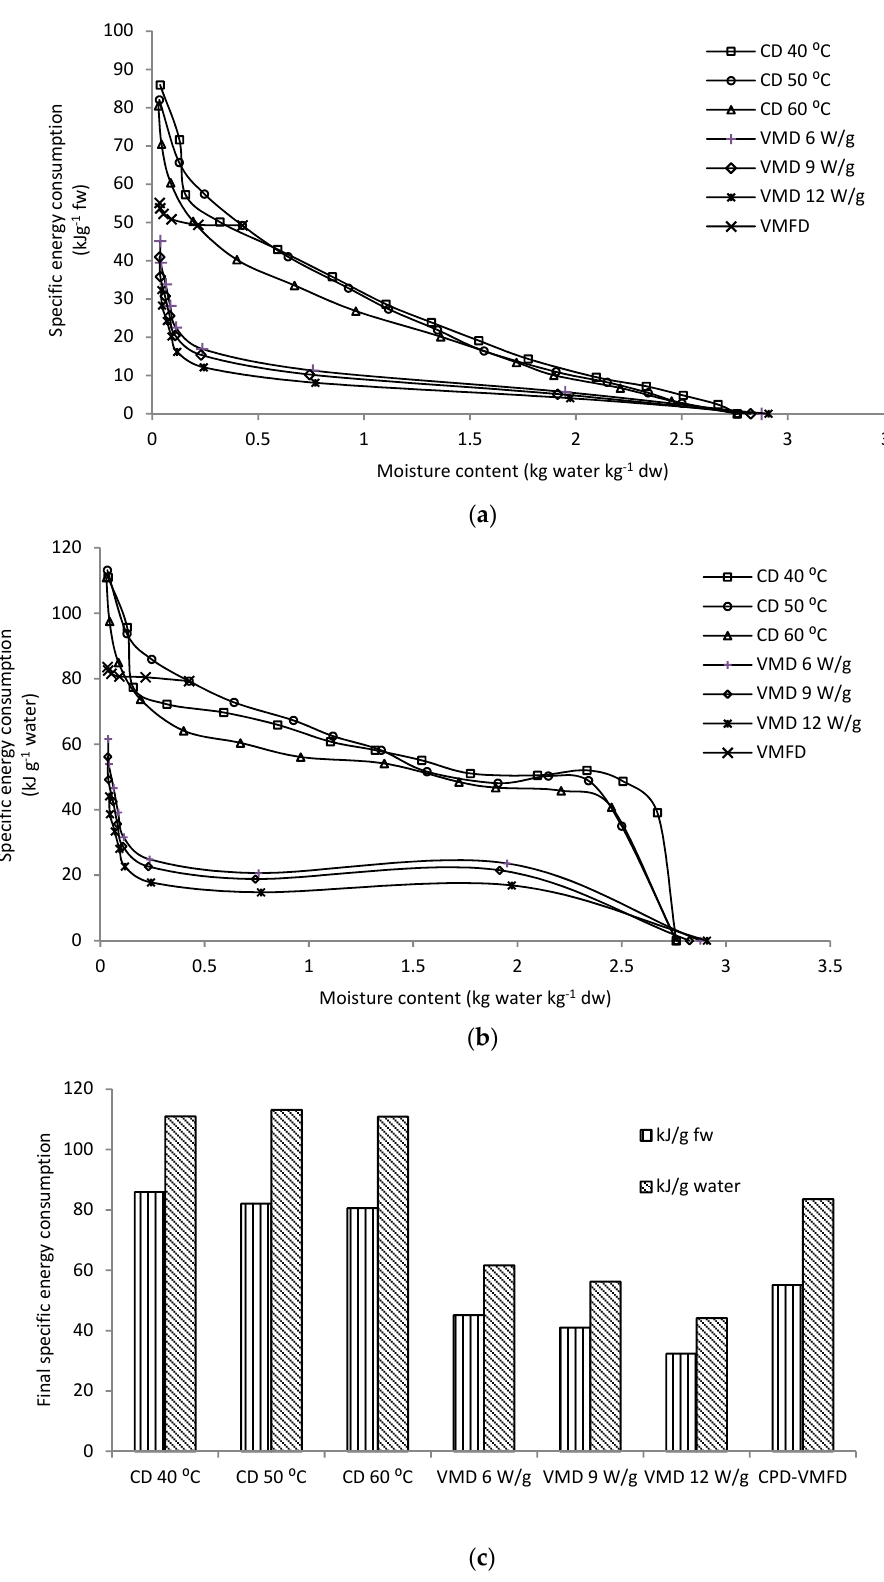
Figure 2. ( a ) Specific energy consumption of C. alata leaves per gram of fresh weight dried using CD, VMD and CPD-VMFD. ( b ) Specific energy consumption of C. alata leaves per gram of water removed using CD, VMD and CPD-VMFD. ( c ) Final specific energy consumptions of CD, VMD and CPD-VMFD of C. alata